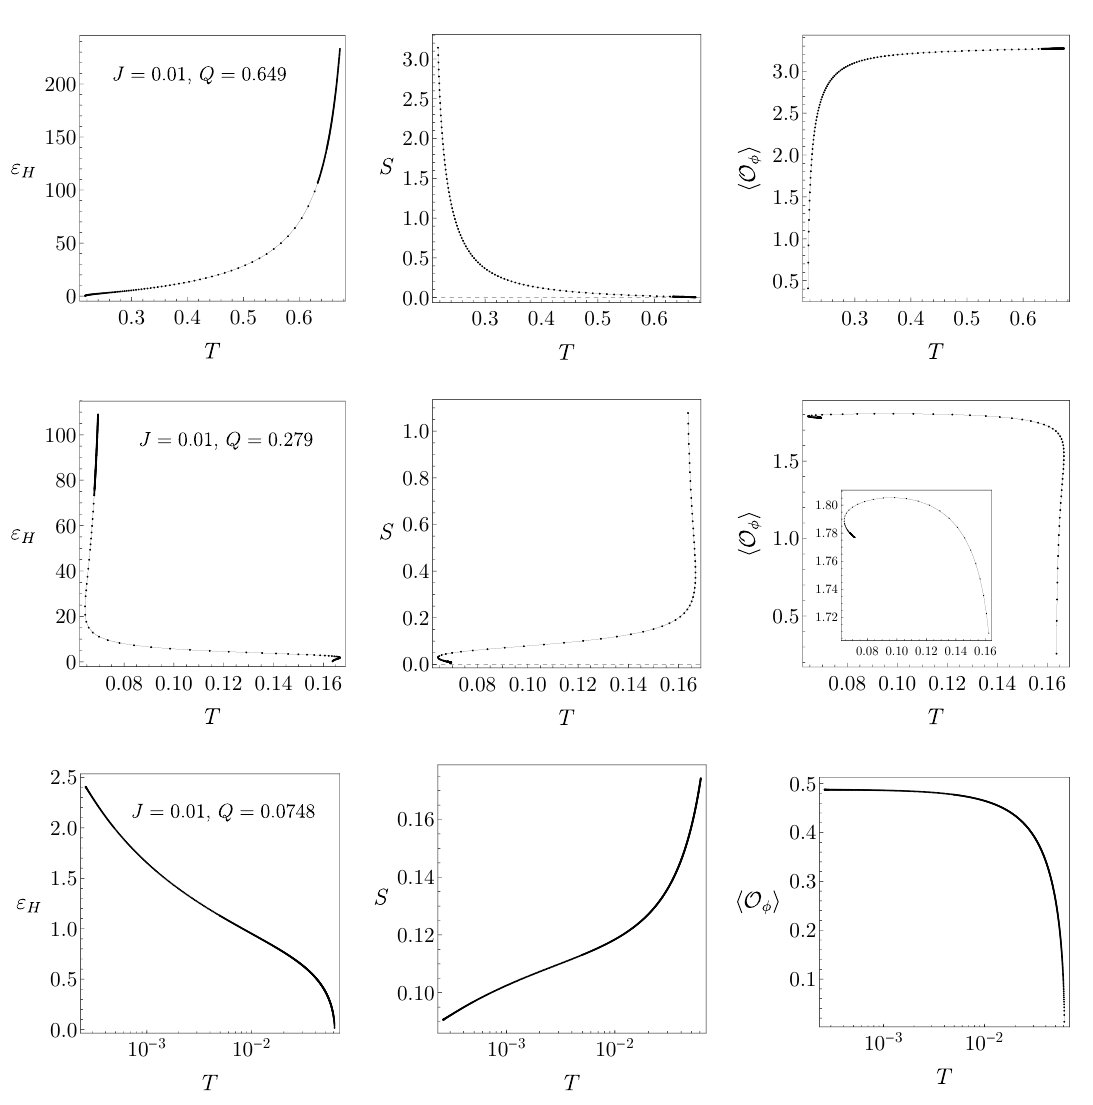
Figure 12 . Constant angular momentum J and charge Q solutions, with the parameter y + being varied. We present the horizon scalar (cid:12)eld " H ( left ), the entropy ( middle ), and the expectation value of the dual operator hO (cid:30) i ( right ), for three di(cid:11)erent charges Q = 0 : 0748 ( bottom row ), Q = 0 : 279 ( middle row ), Q = 0 : 649 ( top row